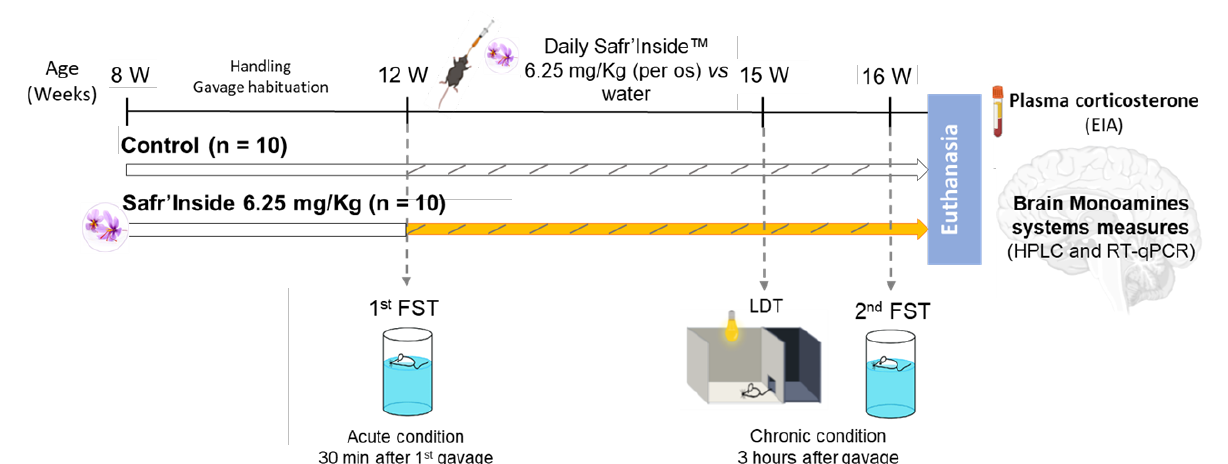
Figure 1. Experimental design to test the effects of acute and chronic administration of Safr’Inside TM (6.25 mg/Kg) on depressive-like behavior and brain monoamines systems.